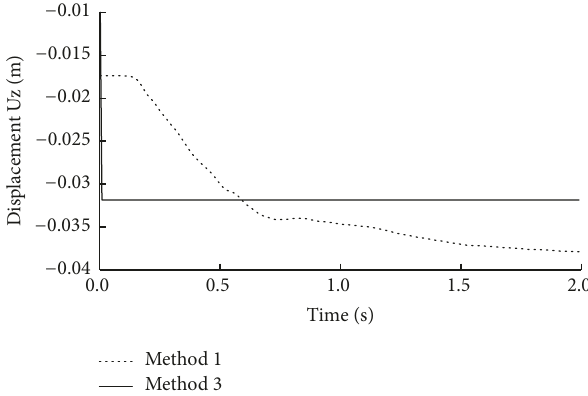
Figure 12: Displacements of Point B under zero dynamic load.